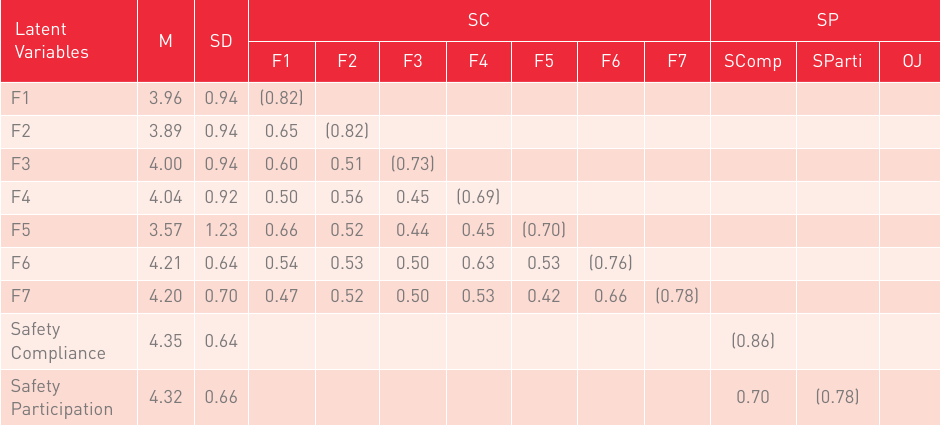
Mean, standard deviation and correlations of latent variables and